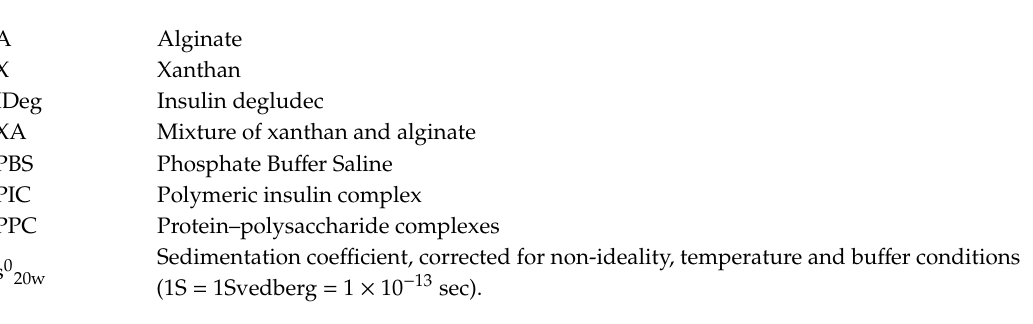
Table S1: Molecular weight and hydrodynamic radius of Xanthan, Alginate and IDeg, Table S2: Intrinsic viscosity (ml / g) of insulin degludec (IDeg), xanthan (X), alginate (A), Binary system containing xanthan and alginate (XA) and PIC measured at 20 ◦ C and 37 ◦ C, Table S3: Results for ANOVA test for PSD of Xanthan (X), alginate (A), Insulin degludec (IDeg), XA, and PIC at a range of temperatures (4, 18 and 37 ◦ C) on Day 1, Day 7, and Day 14, Table S4: MANOVA